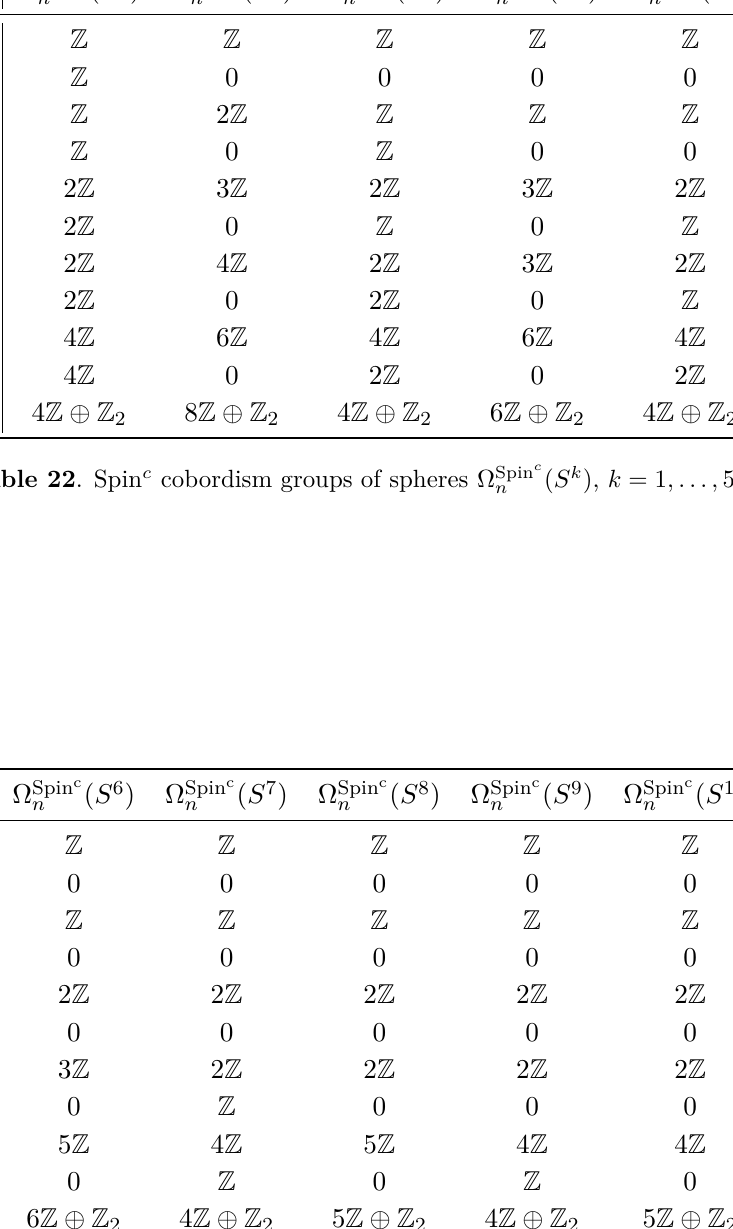
Table 23 . Spin c cobordism groups of spheres Ω Spin c